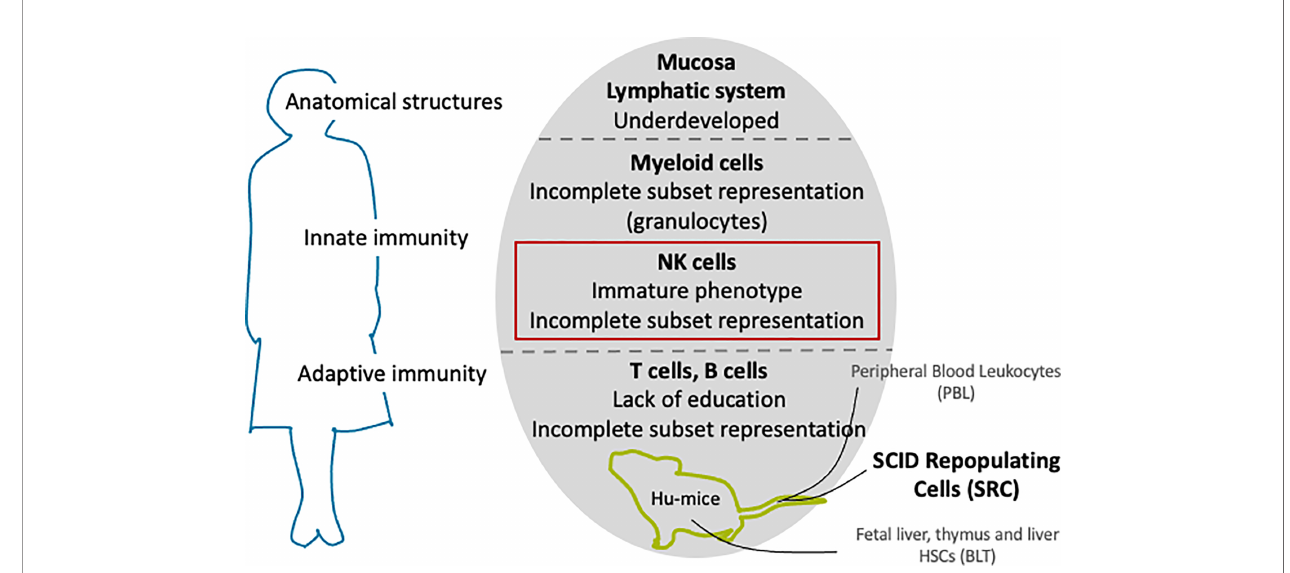
FIGURE 4 | Current challenges in recounstituting a human immune system in immunde fi cient